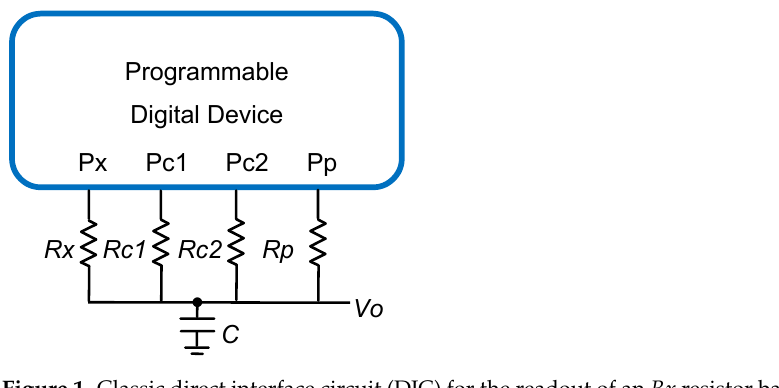
Figure 1. Classic direct interface circuit (DIC) for the readout of an Rx resistor based on the two-point calibration method (TPCM).